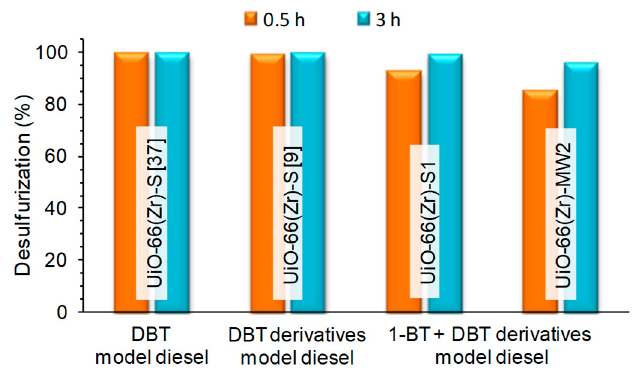
Figure 6. Desulfurization efficiency of UiO-66(Zr) catalysts used in different model diesel sulfur contents under similar experimental conditions (biphasic system model diesel / MeCN system, and H 2 O 2 as oxidant at 50–60 °C [9,37].